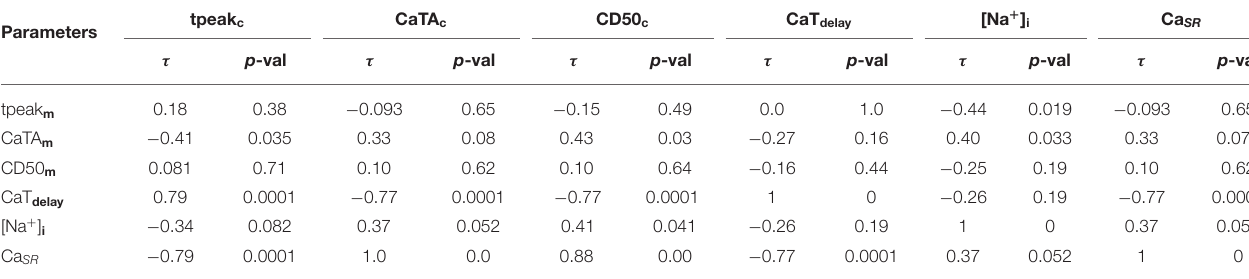
TABLE 6 | Kendall’s τ and corresponding p -values of the correlations between CaT m and CaT c properties, [Na + ] i , and Ca SR . tpeak c CaTA c CD50 Parameters